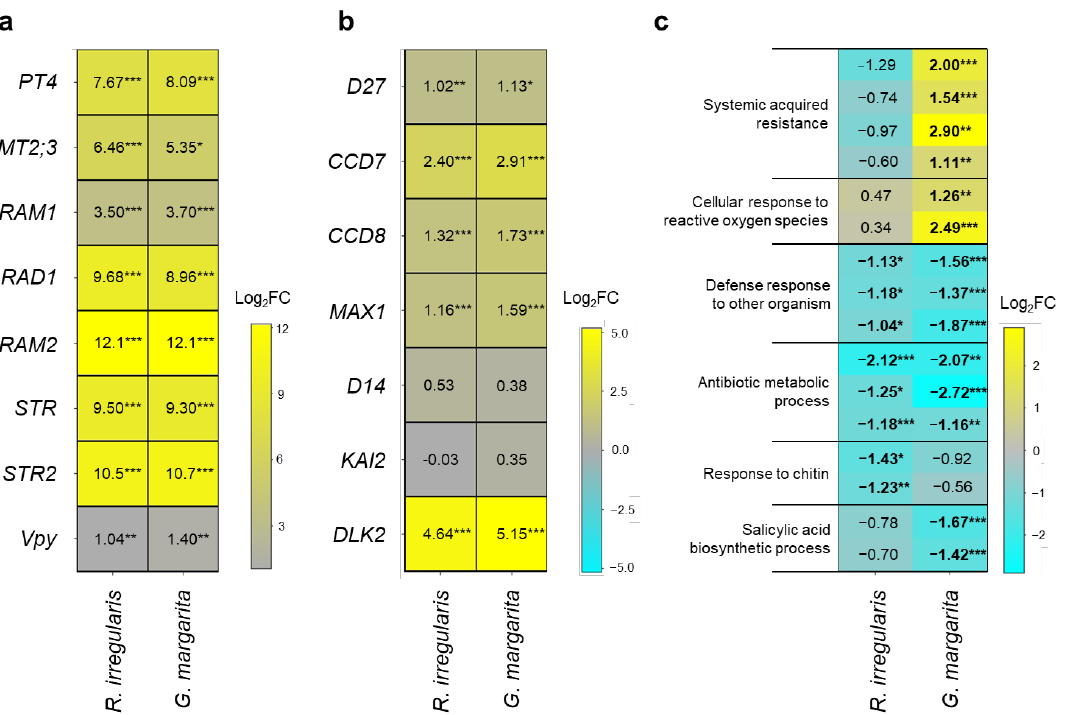
Figure 5. Expression patterns of AM-, strigolactone (SL)-, and defense-related genes during AM symbioses established by different AM fungi in tomato roots. At five weeks post-inoculation (wpi), the transcriptional response of the selected tomato genes against Rhizophagus irregularis or Gigaspora margarita colonization was analyzed. Log 2 -transformed fold changes (FC) of AM-related ( a ) and SL-related ( b ) genes versus the non-colonized roots are presented in each left-hand heatmap. ( c ) The expression patterns of DEGs involved in the defense-related pathways (Figure 4b, Table S3). The calculated values are written on the heatmaps. The Log 2 FC values of DEGs are shown in bold. Asterisks indicate the significance in the Log 2 FC (*: false discovery rate (FDR) < 0.05, **: FDR < 0.01, and ***: FDR < 0.001). The Log 2 FC and FDR values are listed in Table